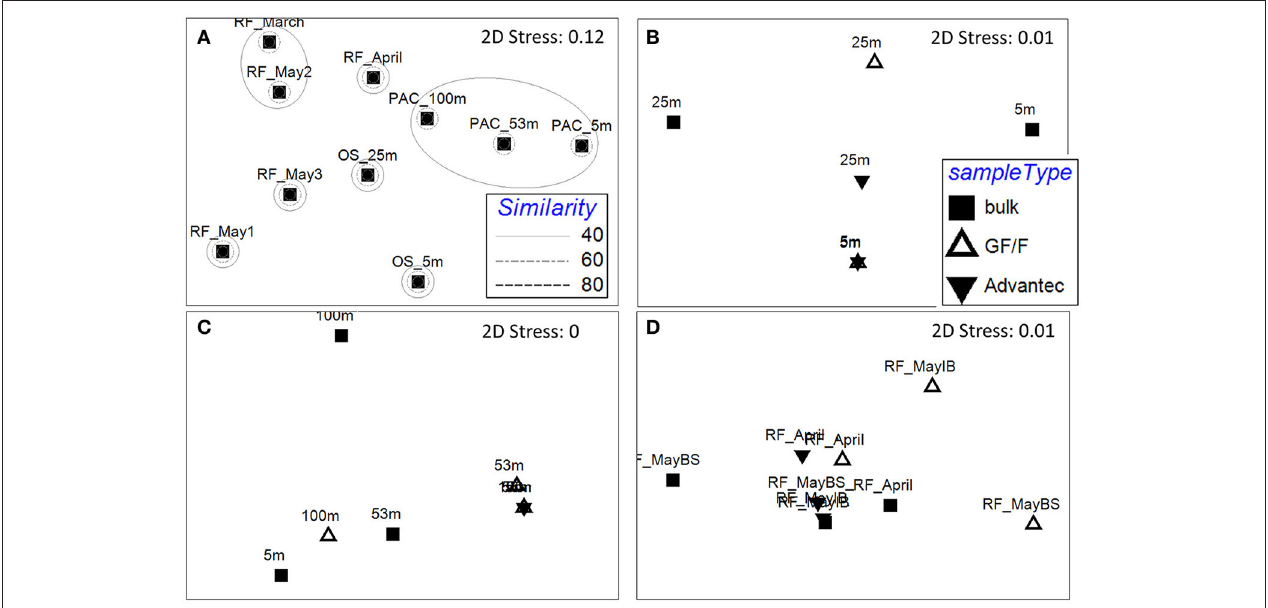
FIGURE 4 | Non-metric multidimensional scaling (NMDS) plots of the diazotroph community composition based on rarefied ( n = 2,000) nifH genes, calculated by Bray-Curtis similarity. (A) Resemblance between bulk samples at the different habitats. Rings mark different similarities (%) between samples, as shown in the legend. RF: Roskilde Fjord; OS: Øresund; PAC: Pacific. B–D ) Resemblance between bulk and filtrate samples in samples from Øresund, Pacific, and Roskilde Fjord, respectively. IB, Inner Buoy; BS, Boundary Station.